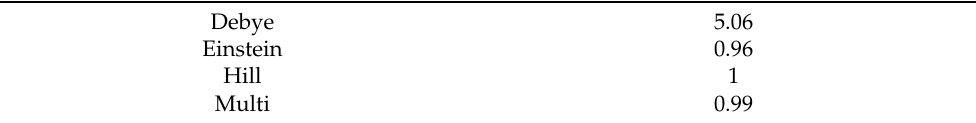
Table 1. Relative heat capacity computation time for compiled C code on an Intel i5-4690K CPU. Debye integration was by the Trapezoidal Rule with 1 Kelvin